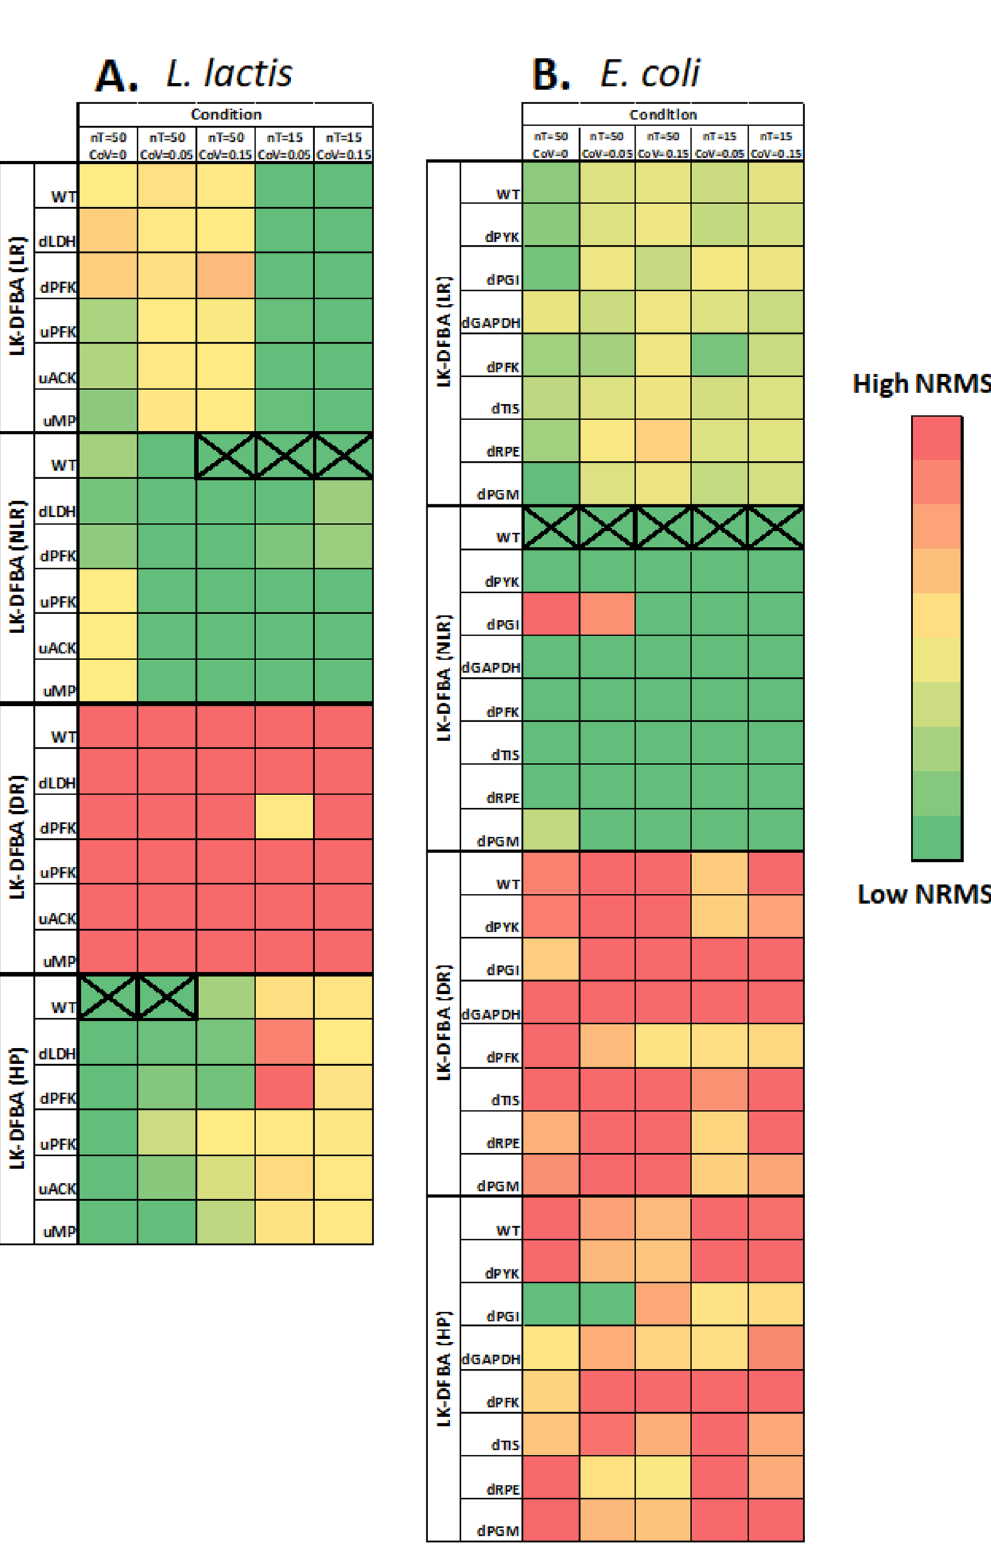
Figure 3. NRMSE heatmaps of constraint approaches on L. lactis and E. coli models. Each constraint approach was used to fit parameters to wild-type (WT) data and then used to simulate the WT system and the system with in silico genetic perturbations with literature-reported important pathways down- or up-regulated. The best constraint approach for each model is indicated with an X. Dark green boxes represent the lowest NRMSE within each phenotype for each model, while dark red boxes represent the highest NRMSE. Both the L. lactis (A) and E. coli (B) heatmaps show the mean of 10 noisy datasets, except for the noiseless condition (leftmost columns in each heatmap). The same NRMSE heatmaps with explicitly annotated error values can be found in Fig.